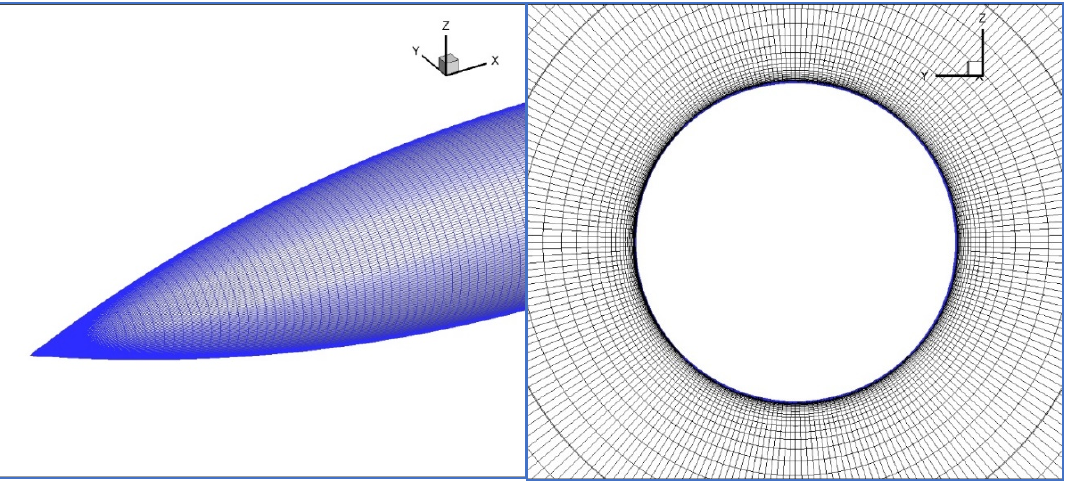
Figure 1. Detail of the structured grid: Left: Surface mesh on the nose. Right: Transversal plane y-z.